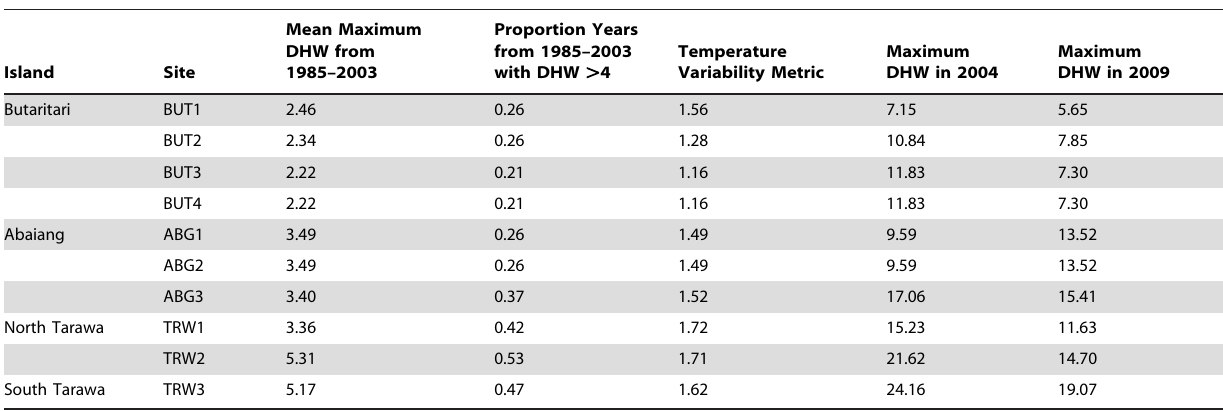
Table 1. Thermal history metrics calculated for each site.